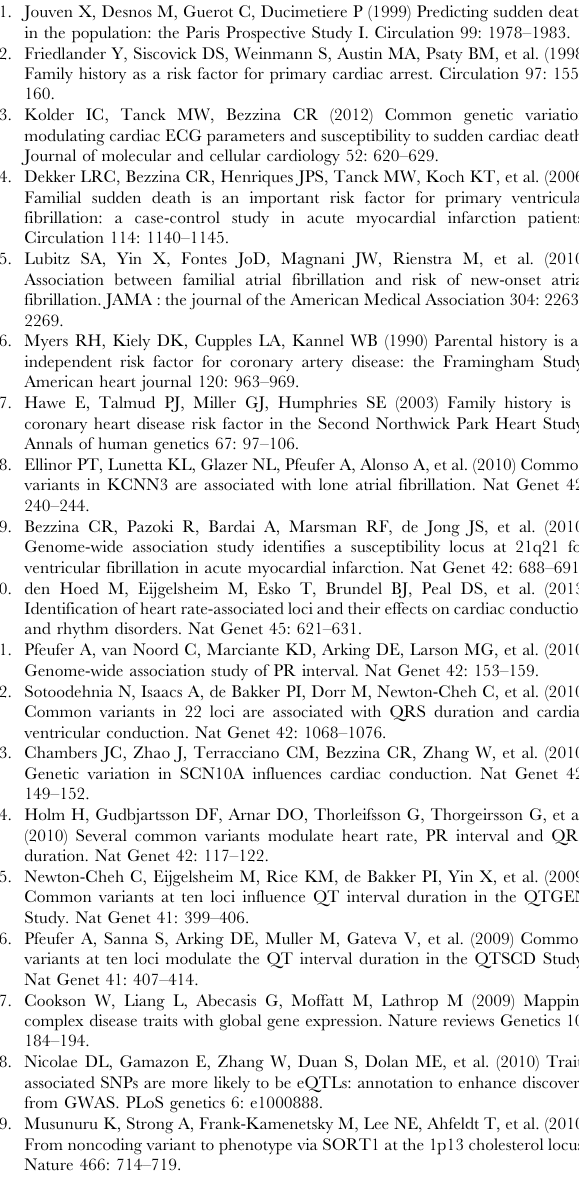
allele frequency, beta (effect size per copy of the minor allele), p- value and distance between SNP and gene. The table is sorted on HGNC official gene